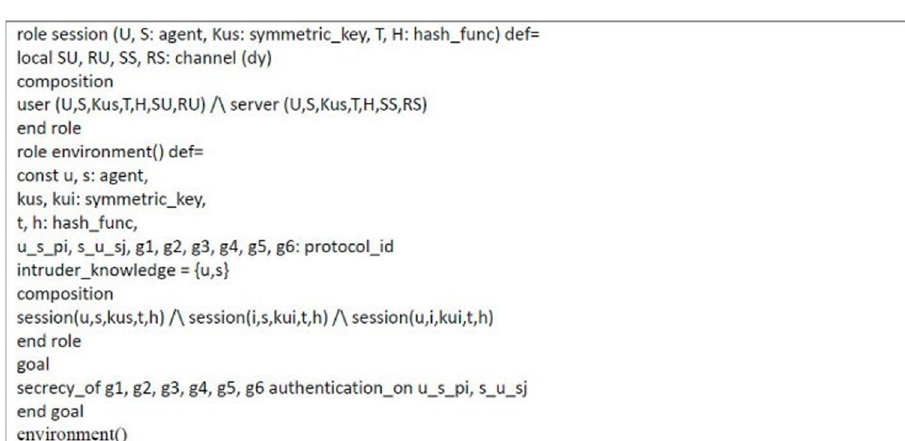
Figure 7. HLPSL specification of server.